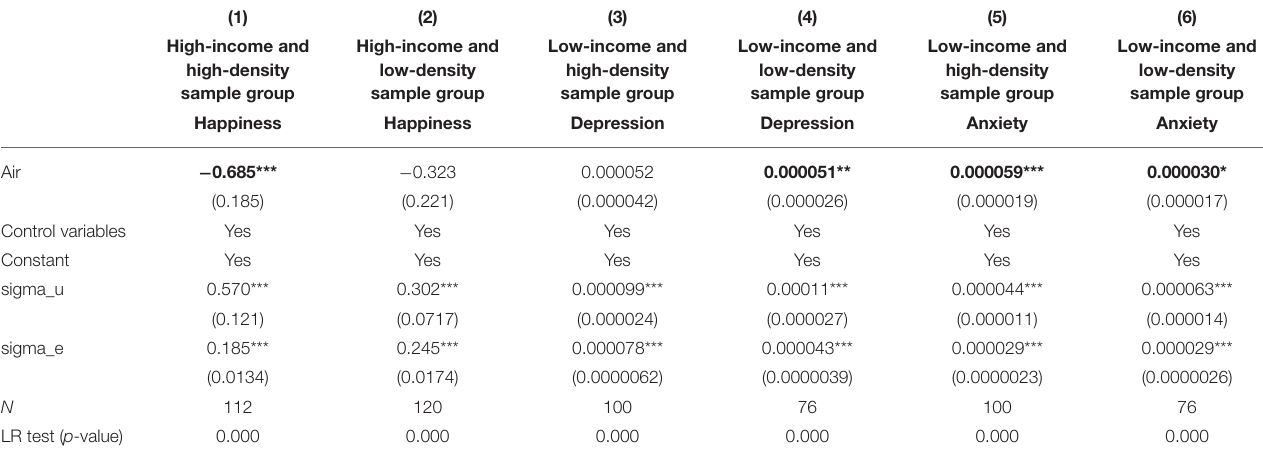
TABLE 11 | Heterogeneity test of population density with different